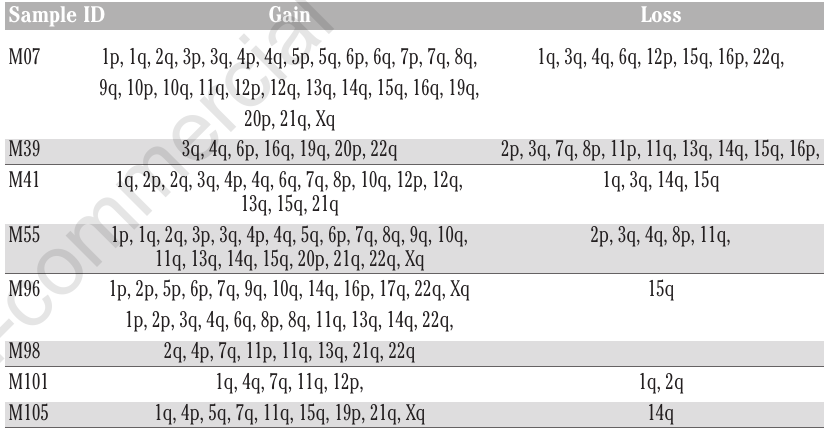
Table 2. Chromosomal aberrations (gains and losses) in eight multiple myeloma patients.